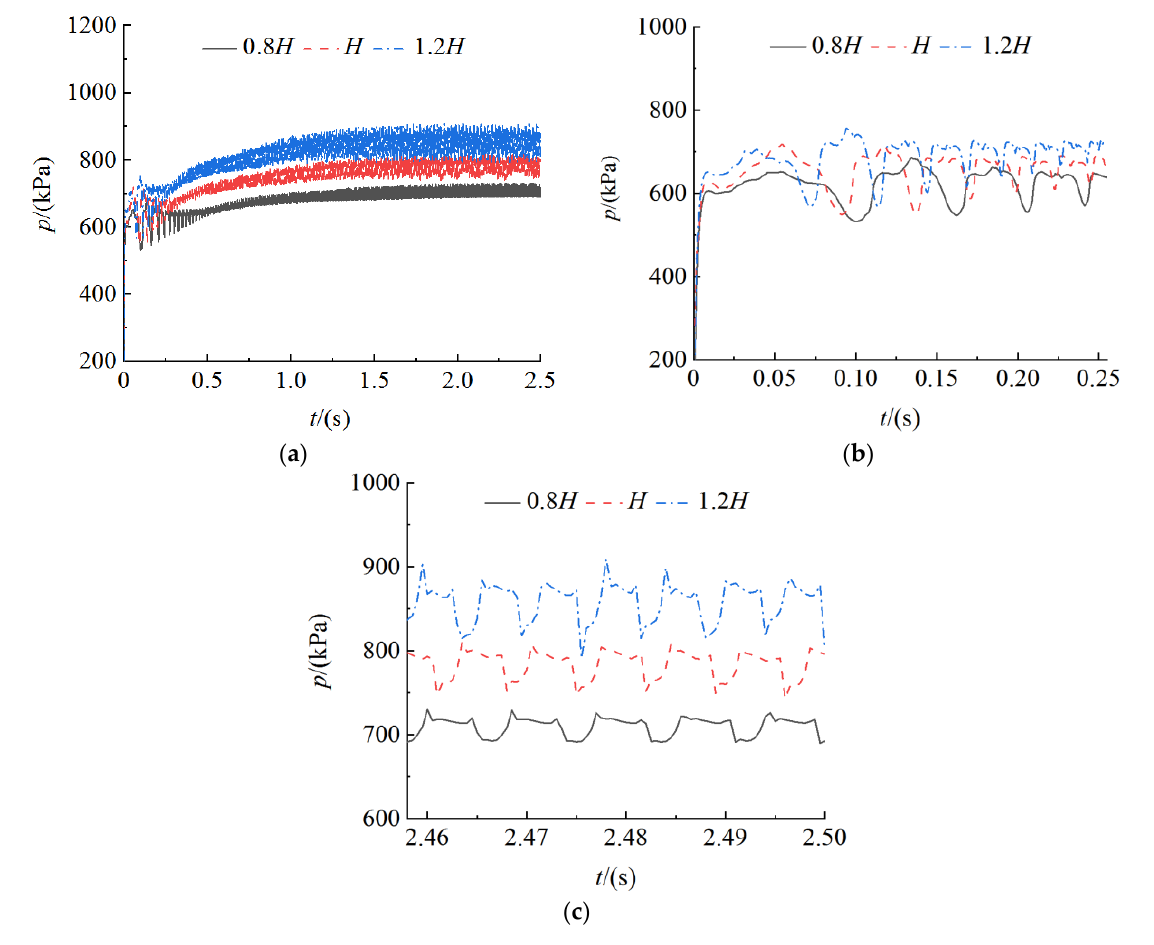
Figure 17. Time domain of pressure fluctuation at various head in volute. ( a ) t = 0~2.5 s; ( b ) t = 0~0.255 s; ( c ) t = 2.458~2.5 s.